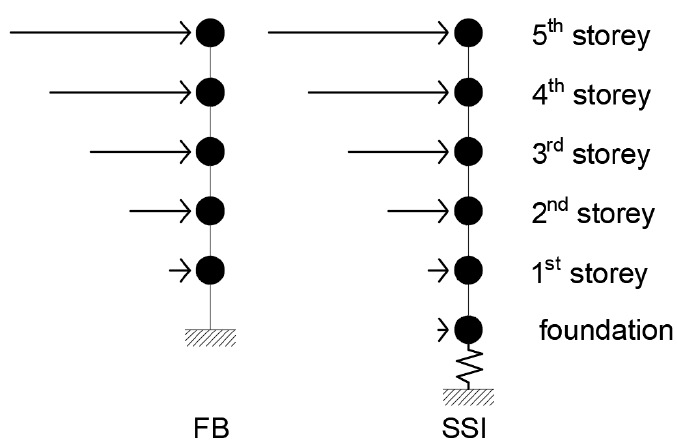
Figure 10. Force-deformation ( P - y ) relation assigned to corner column, edge column and middle column.